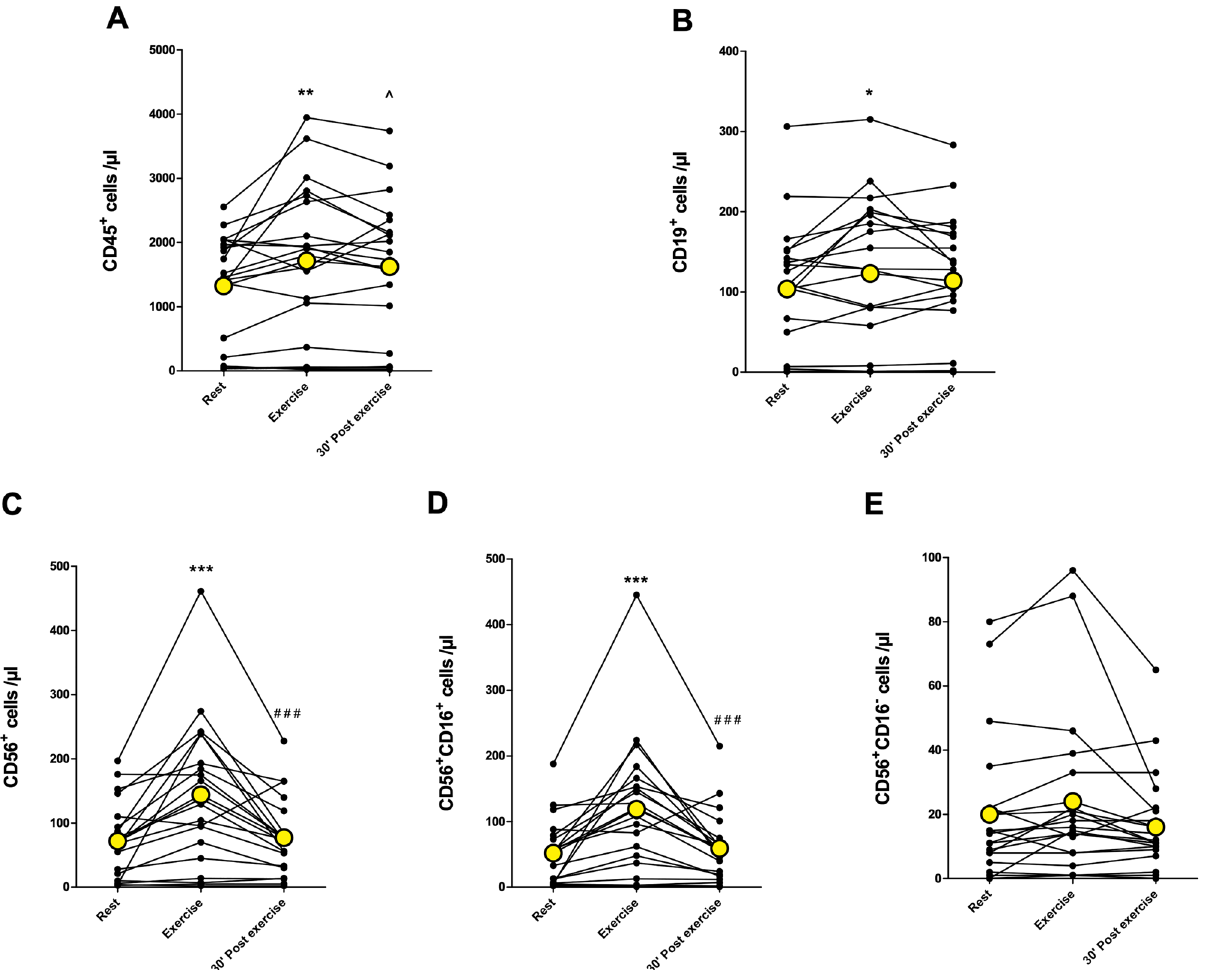
Figure 2. The number of total leukocytes, B cells, and NK cells at rest, immediately after and 30 min after acute exercise. ( A ) Leukocyte (CD45 + ) count increased significantly immediately after exercise and was above baseline after 30 min post-exercise. ( B ) The number of B cells (identified as CD45 + CD3 − CD19 + cells) increased significantly immediately after exercise. ( C ) Total NK cell (identified as CD45 + CD3 − CD56 + cells) and ( D ) CD56 + CD16 + NK cell count increased significantly immediately after exercise and decreased to baseline levels at 30 min post-exercise. ( E ) Acute exercise had no significant effect on CD56 + CD16 − NK cells. Yellow points represent the mean. * p < 0.05 between rest and exercise; ** p < 0.01 between rest and exercise;*** p < 0.001 between rest and exercise; ^ p < 0.05 between rest and 30 min post-exercise; ### p < 0.001 exercise and 30 min post-